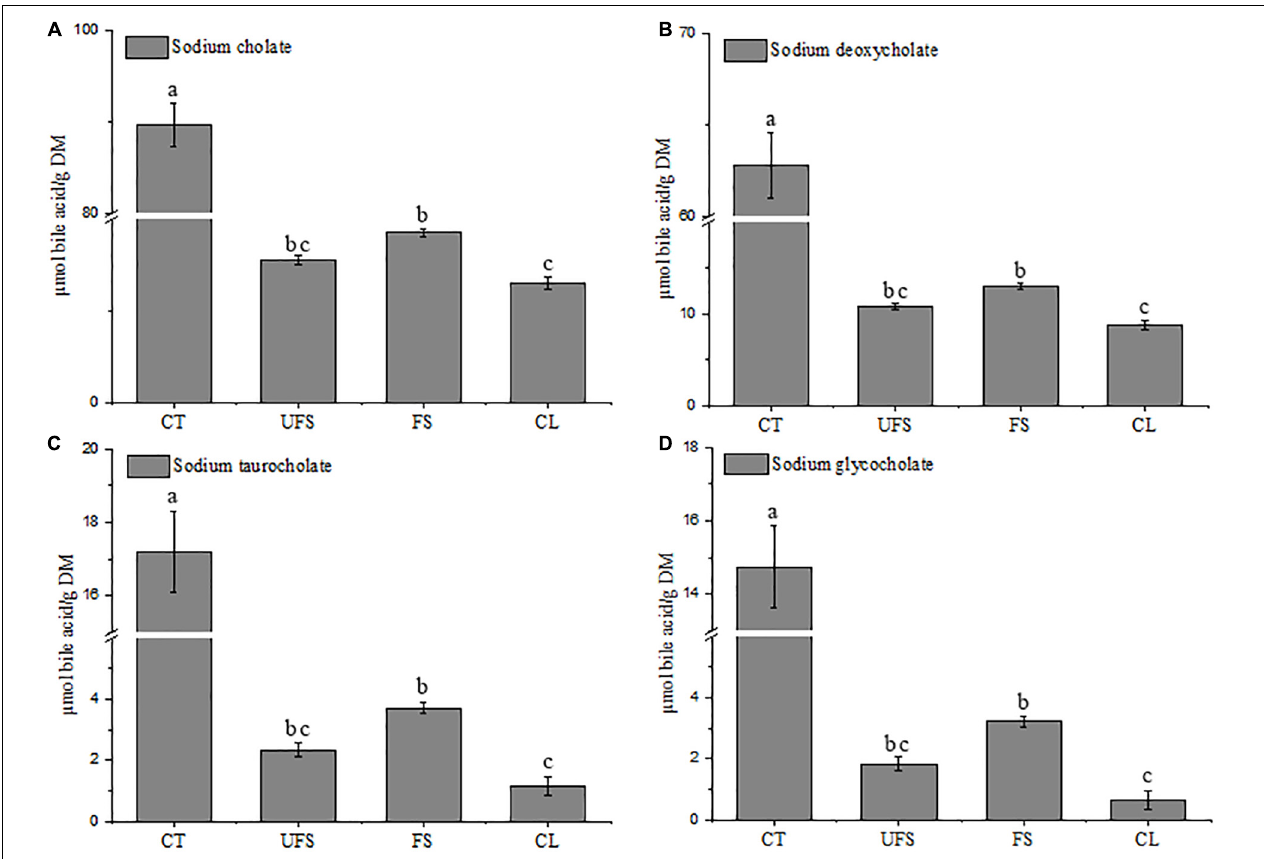
FIGURE 2 | Bile acid binding capacity of unfermented seaweed extracts and fermented seaweed extracts. (A) Sodium cholate, (B) sodium deoxycholate, (C) sodium taurocholate, (D) sodium glycocholate. CT, cholestyramine; UFS, unfermented seaweed extracts; FS, fermented seaweed extracts; CL, cellulose. Data were done in triplicates and represented as mean ± SD. p < 0.05 is indicated by different letters.